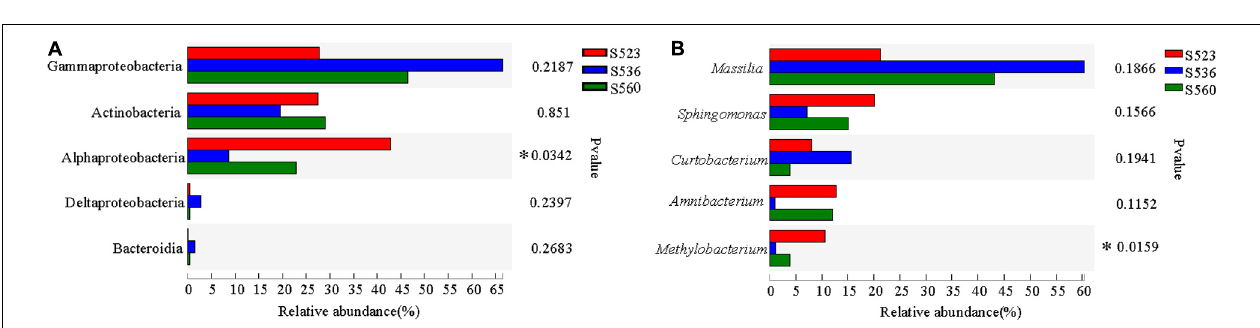
FIGURE 2 | Differences in the dominant bacterium at the class (A) and genus (B) level over different phytoremediation years ( P < 0.05).